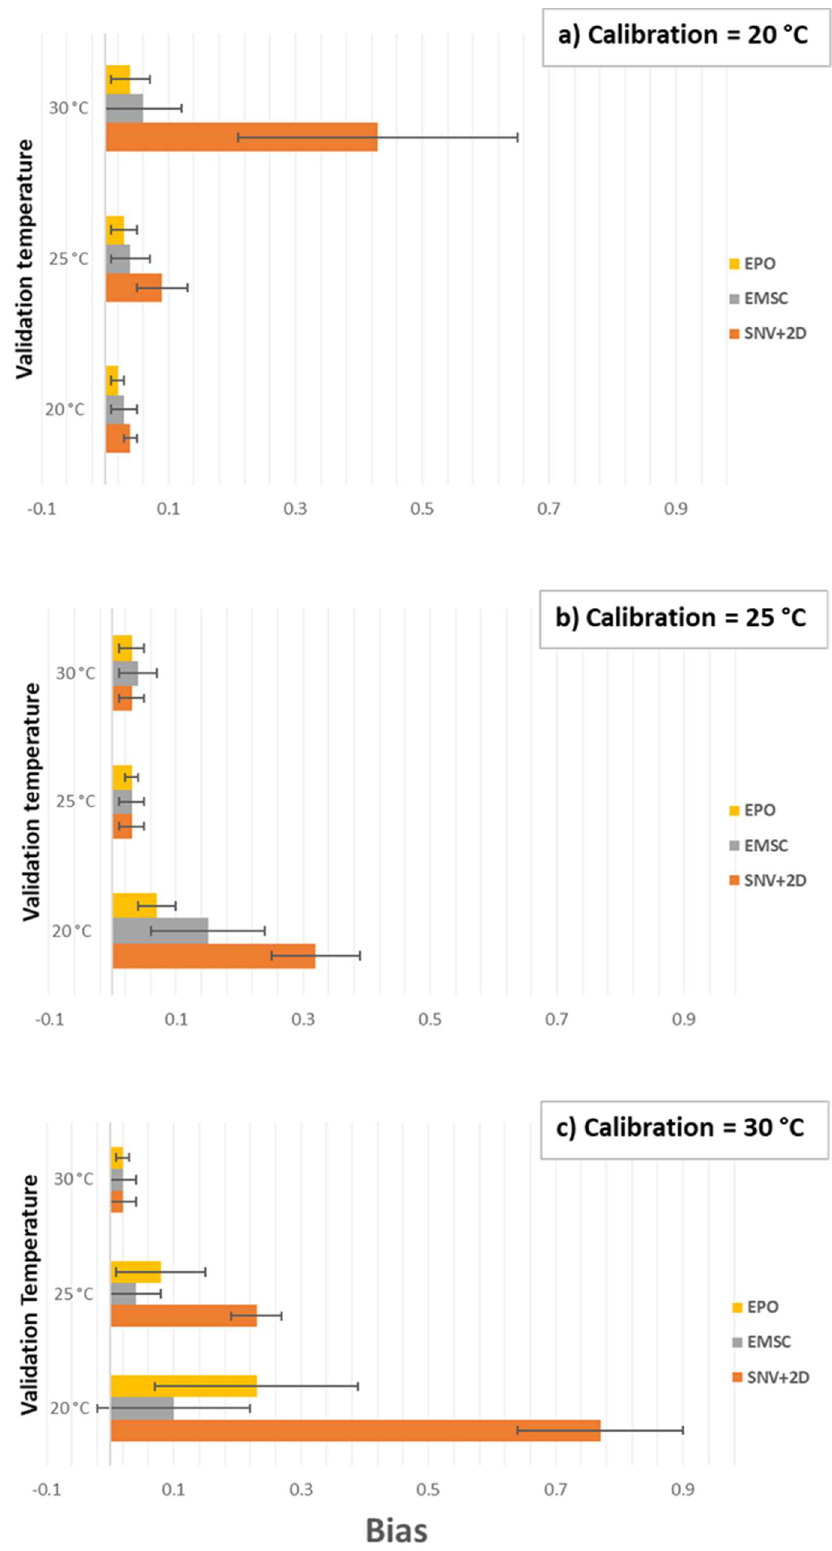
Figure 9. Validation temperature vs. bias at for SSC prediction of kiwifruit juice in the first overtone (1300–1600 nm) region of the OH stretch of water at calibration temperature ( a ) 20 °C, ( b ) 25 °C, and ( c ) 30 °C. Error bars show standard deviation.